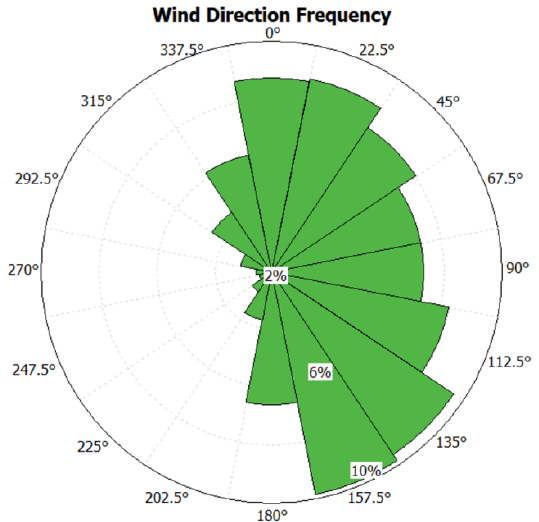
Figure 7. Wind direction rose of 1824#.